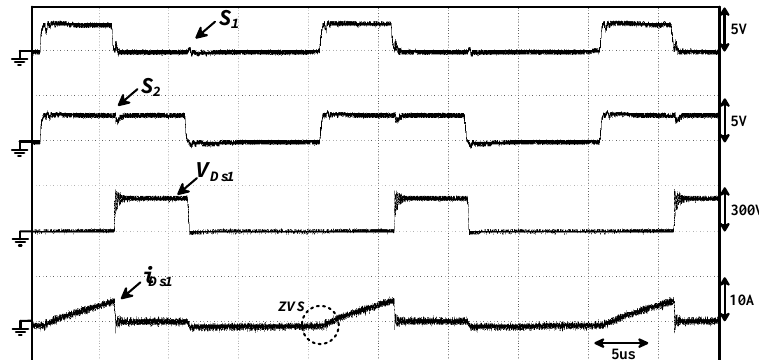
Figure 23. Experimental results for (top) switching control signals S 1 , S 2 and (bottom) corresponding voltage and current of switch S 1 during negative half line cycle.